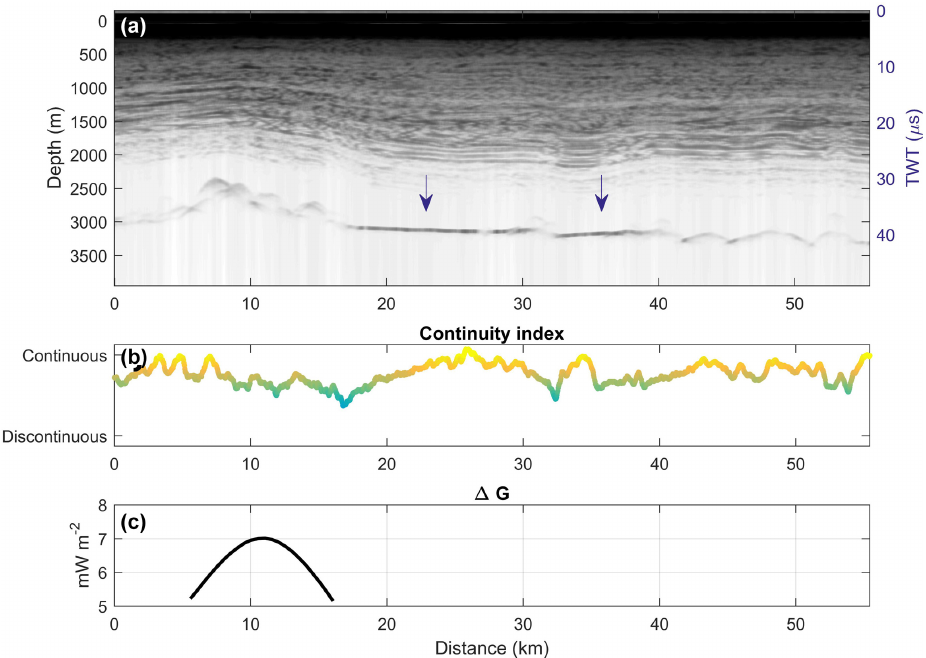
Figure 5. (a) Radargram (Z-scope) with two clear lakes indicated with blue arrows. The location of the radargram is indicated on Fig. 5. (b) Continuity index along the radargram. (c) Calculated (cid:49)G assuming a maximum allowed horizontal velocity of < 2ma − 1